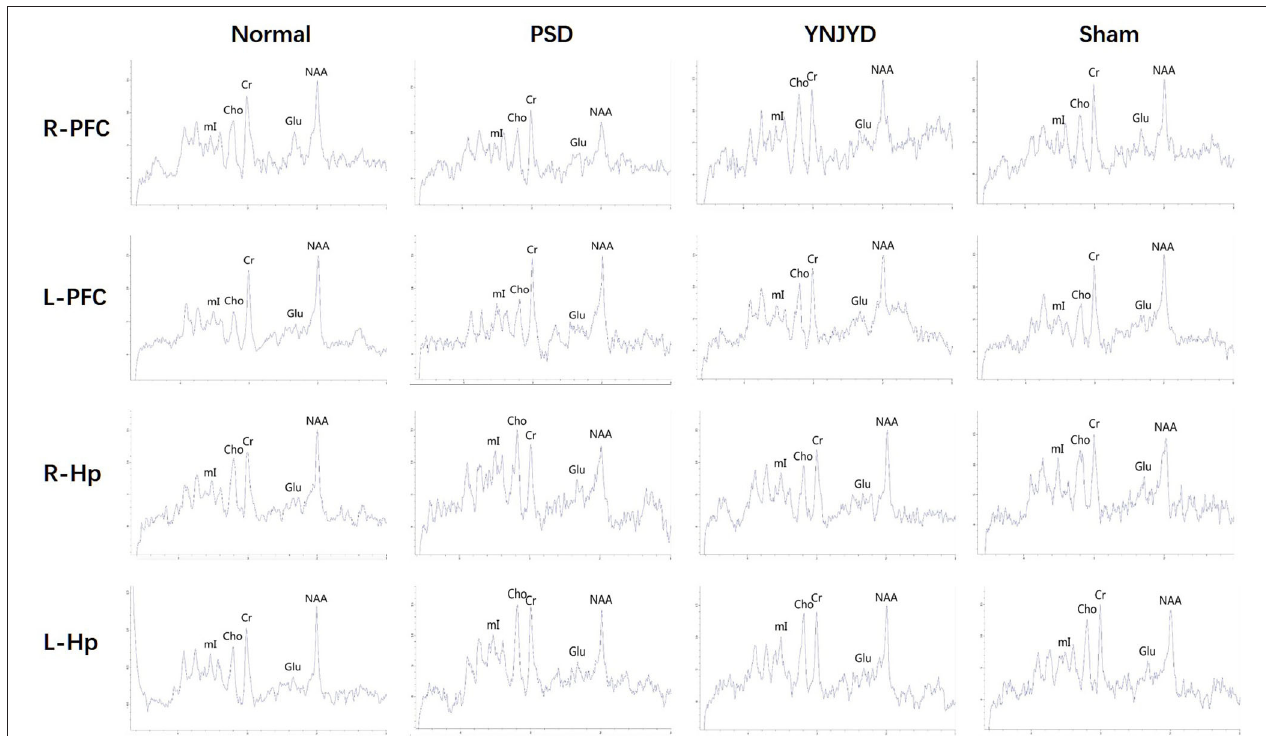
FIGURE 8 | Representative magnetic resonance spectroscopy (MRS) spectra from the right (R) and left (L) prefrontal cortex (PFC) and hippocampus (HP) of normal, post-stroke depression (PSD), YNJYD-treated, and sham-operated rats. 1 H MRS exhibits a creatine (Cr) peak at 3 ppm, an N-acetyl aspartate (NAA) peak at 2 ppm, a choline (Cho) peak at 3.2 ppm, a glutamate (Glu) peak at 2.2 ppm, and a myo-inositol (mI) peak at 3.6 ppm. Quantification of the relative ratio of each metabolite to Cr in each of the regions of interest